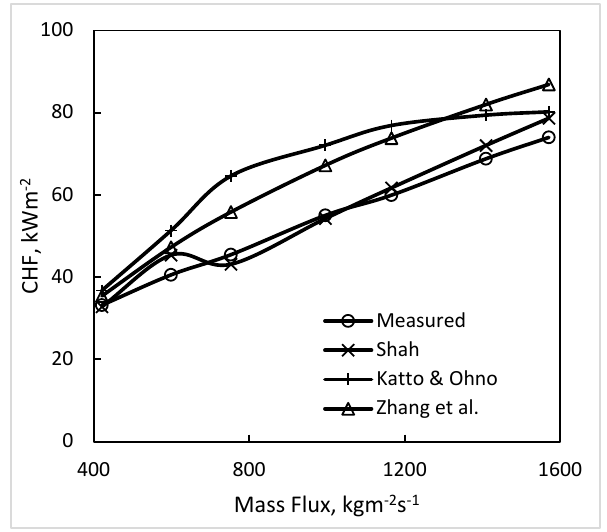
Figure 7. Comparison of data from Celata et al. (1994b) [15], Shah [23], Katto and Ohno [16] and Zhang et al. [25] for the R-12/R-114 mixture of 0.787/0.223 mole in tube with some general correlations. Pressure is 2.8 MPa, and inlet subcooling is 23 K.